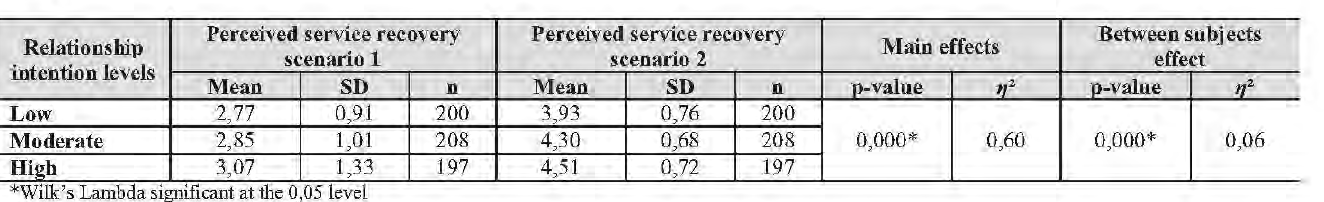
Table 6: Relationship intention and differences between perceived service recovery after service recovery scenarios 1